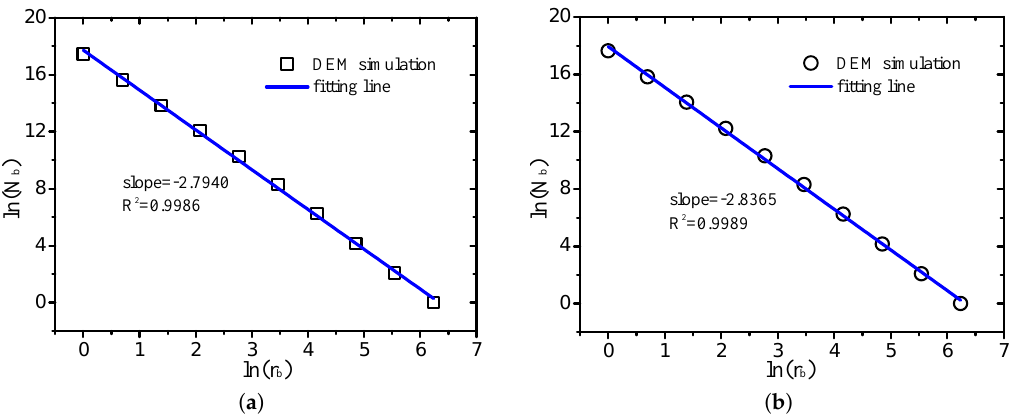
Figure 10. Log-log plots of box size and number of boxes covering pore (( a ) µ p = 0.0, D = 2.9; ( b ) µ p = 0.7, D =